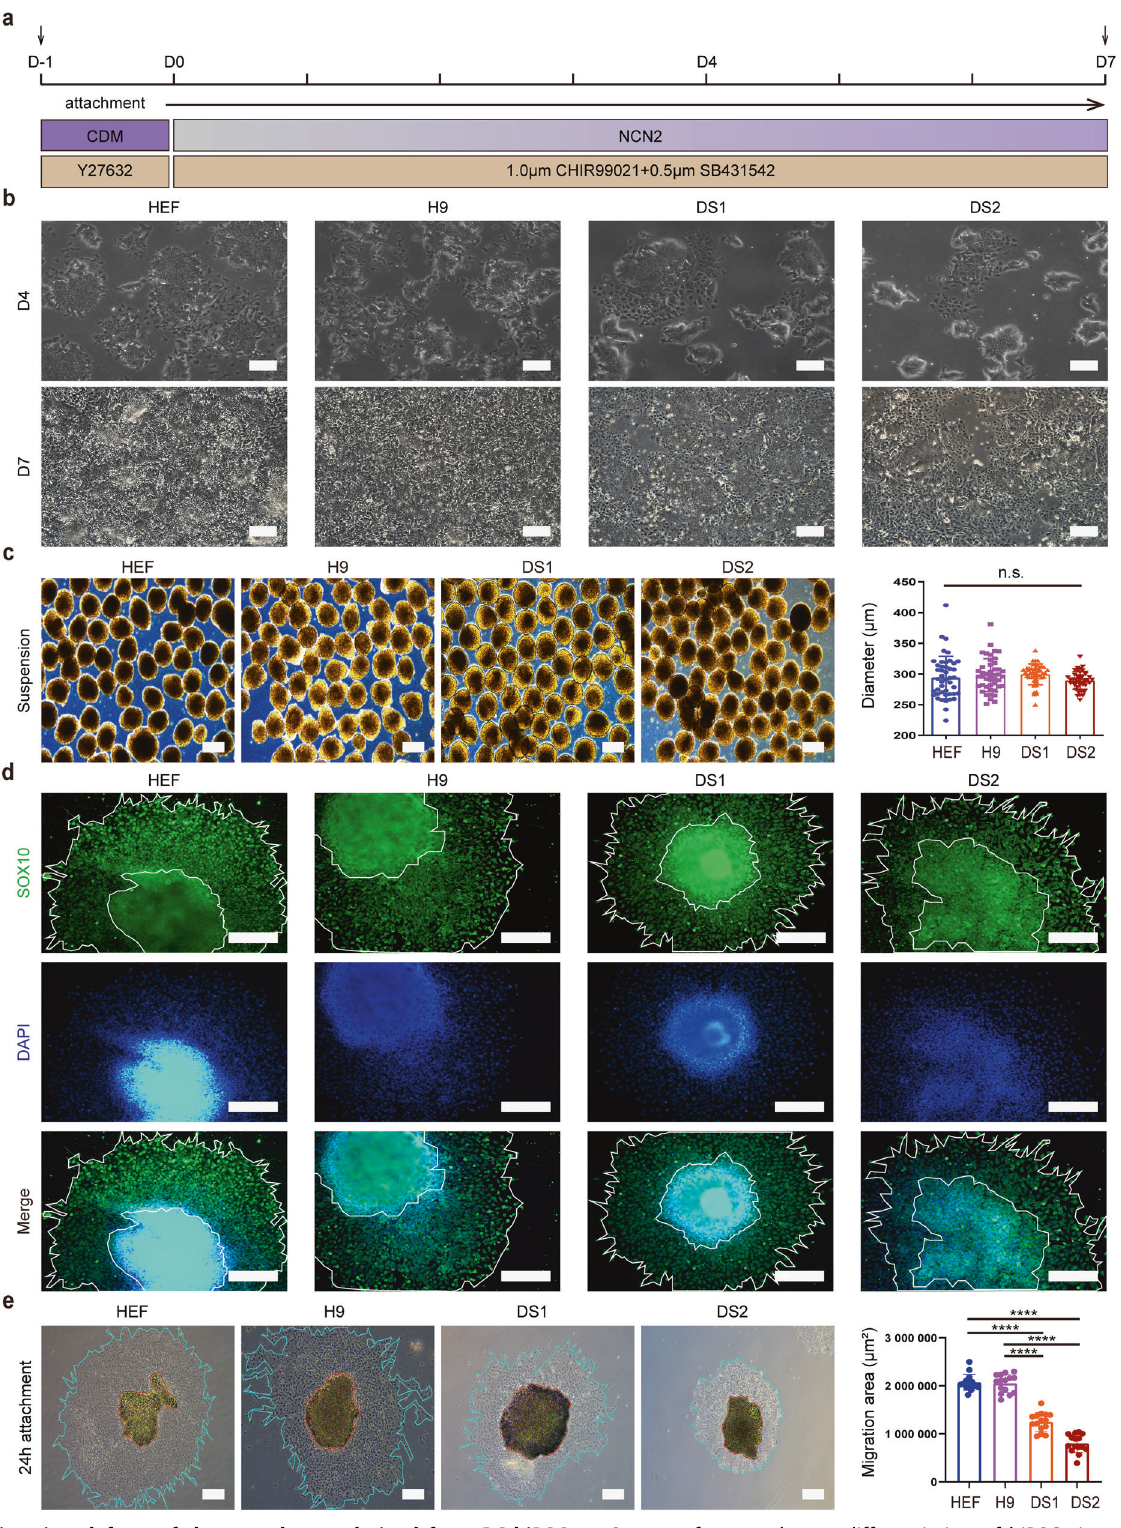
Fig. 1 Migration defects of the neural crest derived from DS-hiPSCs. a Strategy for neural crest differentiation of hiPSCs in monolayer cultures. b The morphology of differentiated cells was observed using phase-contrast microscopy on day 4 (D4) and day 7 (D7) during neural crest differentiation. c Day 7 differentiated cells formed spheres when cultured in suspension for 24 h and the diameter of the spheres was calculated and compared ( n = 45; one-way ANOVA; n.s. not signi fi cant). d The expression of a neural crest-speci fi c marker (SOX10) was detected by immunostaining when spheres were seeded onto Matrigel-coated plates. e Cells were observed under a phase-contrast microscope at 24 h after attachment of spheres and cell migration area in different groups was calculated and compared ( n = 15; two-tailed unpaired Student ’ s t test, **** P < 0.0001). Data are presented as the mean ± SD of three independent experiments. Scale bar: 250 μ m.